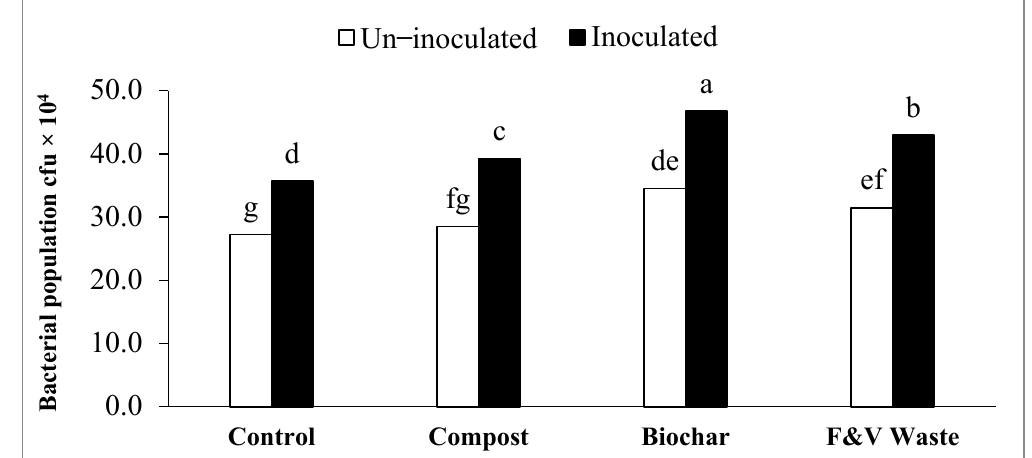
Figure 4. Effect of biochar, fruit and vegetable waste, compost and Bacillus subtilis SMBL 1 on bacterial CFU of soil with un-inoculated treatment set (Control = no bacterial inoculation) and inoculated treatment set (Control = SMBL 1 only). Different letters indicate significant differences according to least significant difference test at ( p ≤ 0.05).